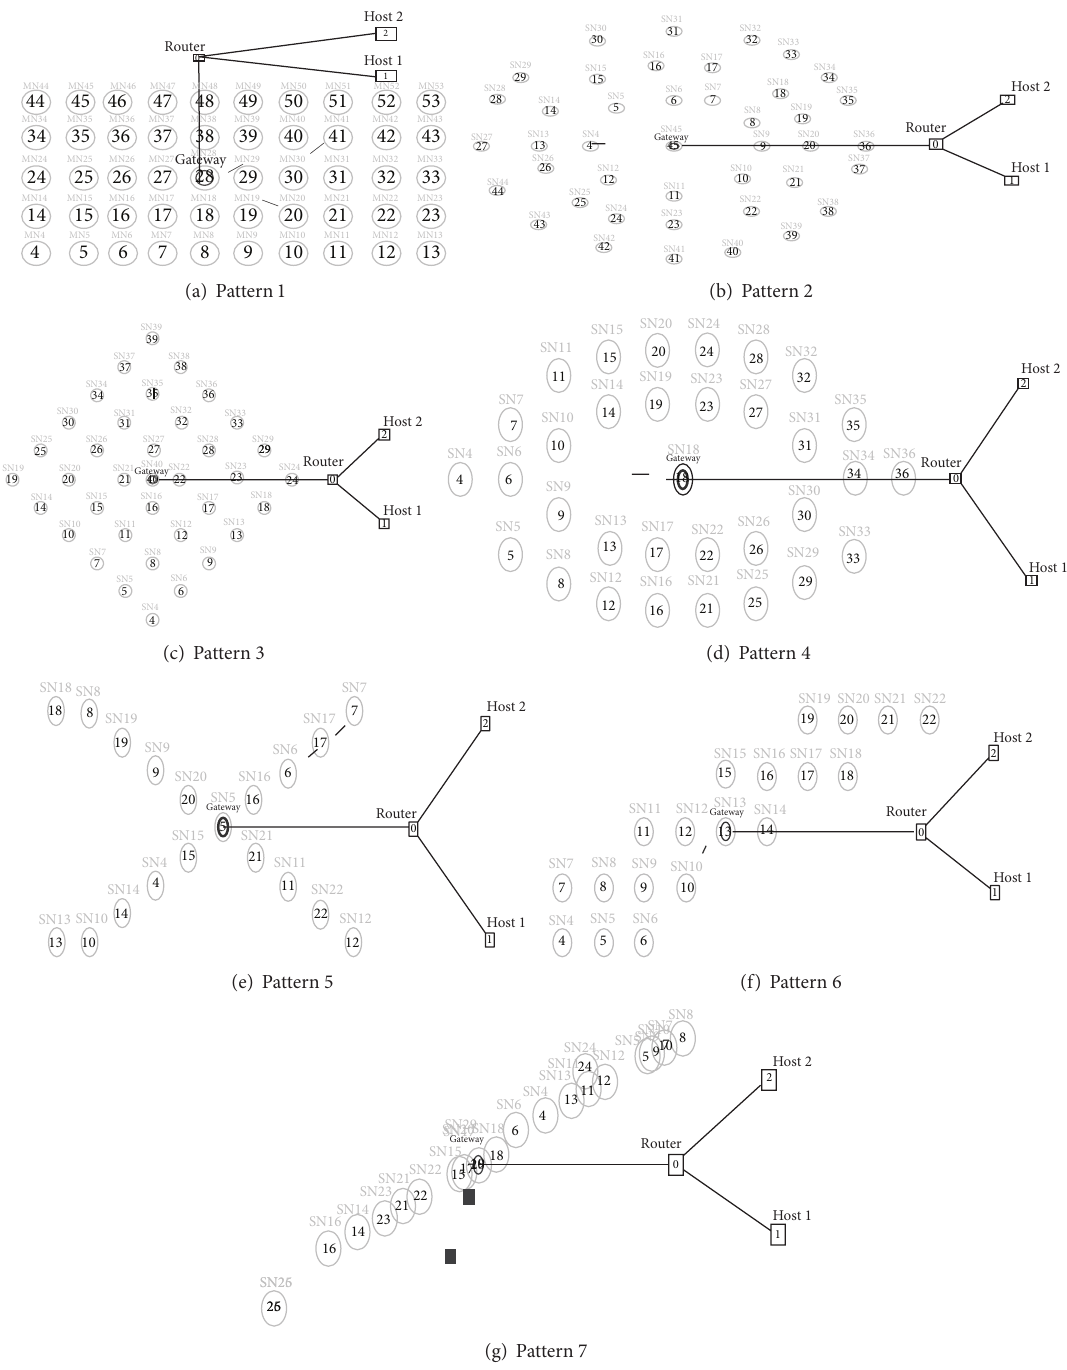
Figure 4: Various WSN pattern